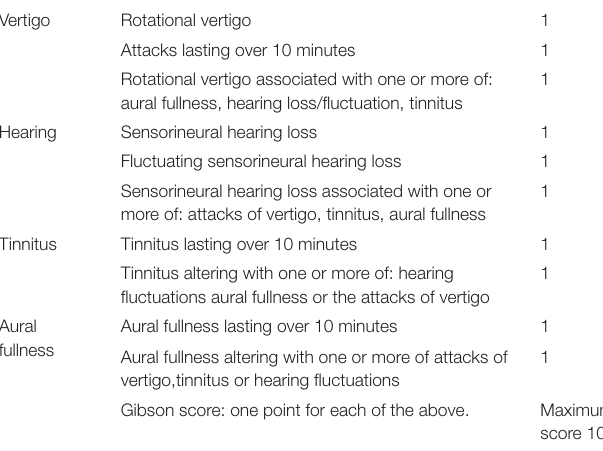
TABLE 1 | The Gibson 10 point score (Gibson,